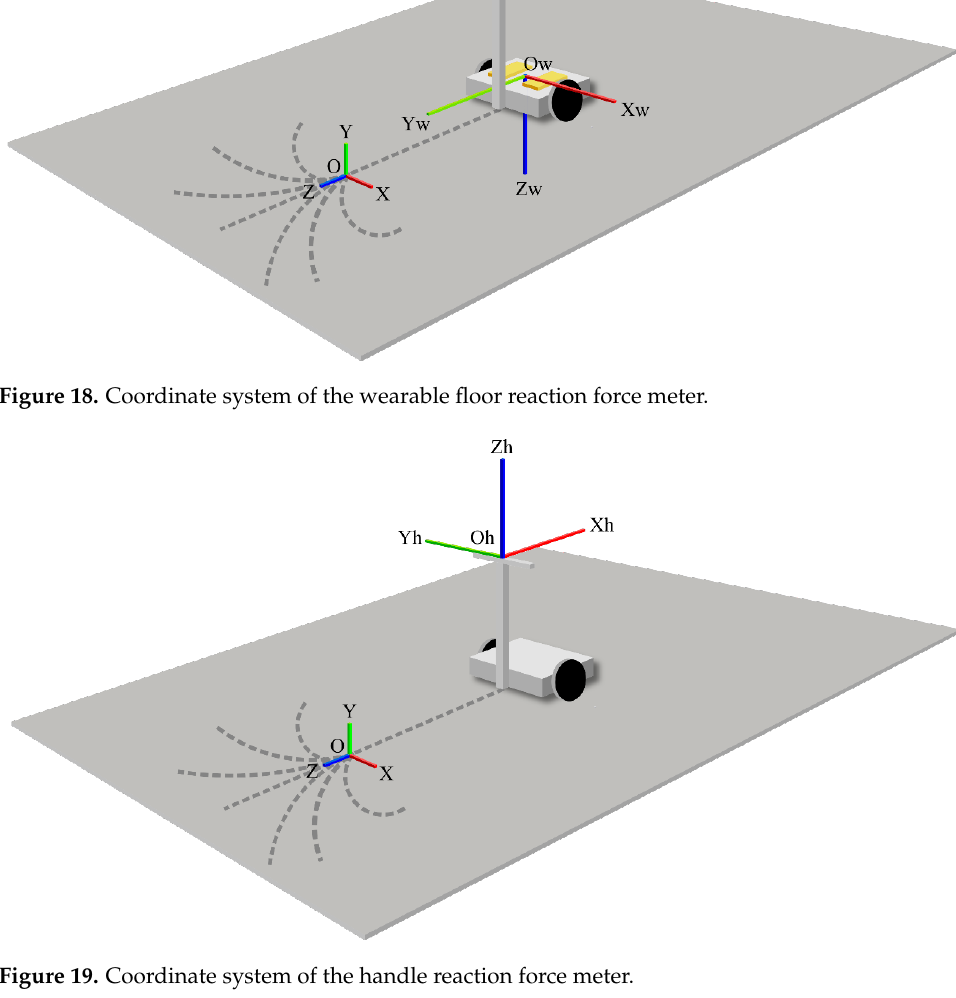
Figure 19. Coordinate system of the handle reaction force meter.